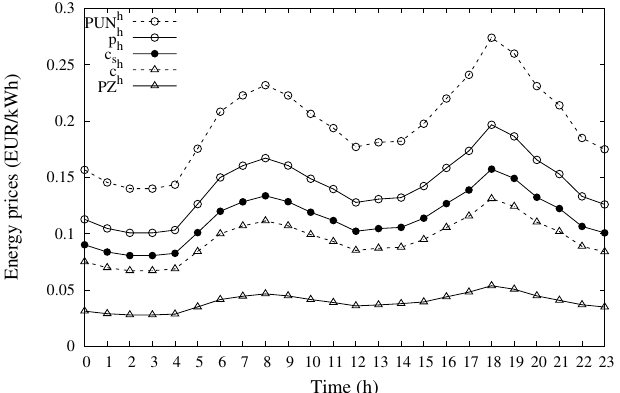
Figure 4. Example of daily trends for the costs and prices of electrical